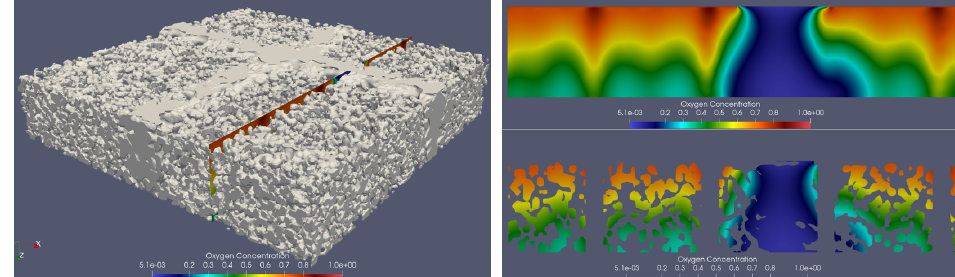
Figure 17. Detailed information about oxygen concentration within the hydrogel for the case with two outlets. ( Left ): 3D hydrogel with a 2D slice. ( Right ): A section of the 2D slice through hydrogel containing details of oxygen concentration (top) and hydrogel structure (bottom). Red is high oxygen concentration and dark blue is low oxygen concentration. Maximum oxygen concentration was 1.06 × 10 − 7 mol/cm 3 . The flow is from top to bottom. The dark red colors with high concentration indicate where the ultrafiltrate channels a